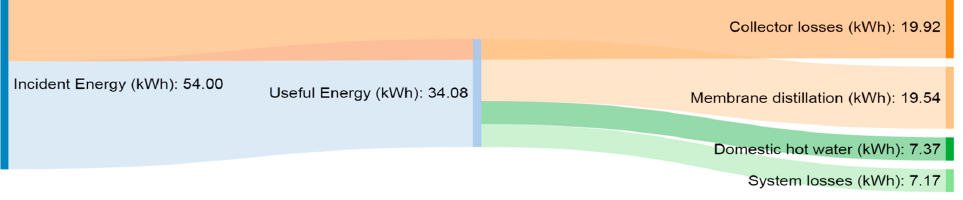
Figure 13. Energy flows in SCMD system.